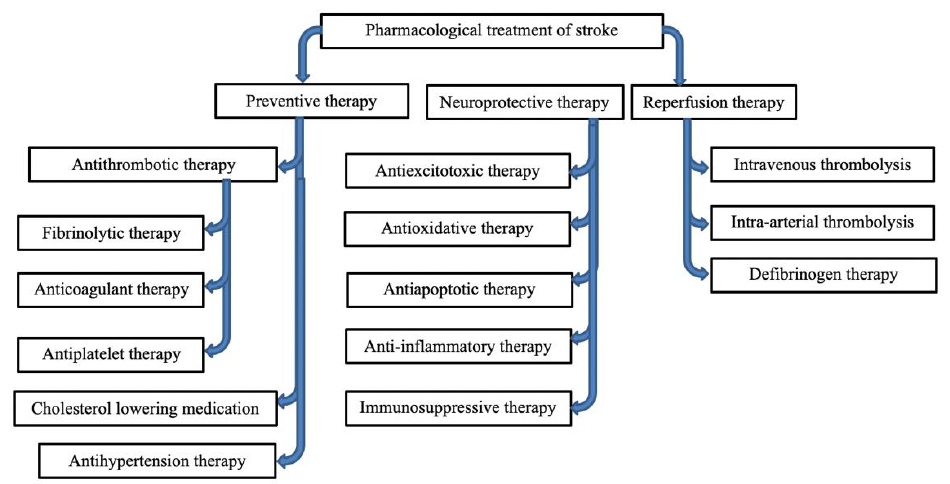
Figure 3. Summarized table of the pharmacological treatment of